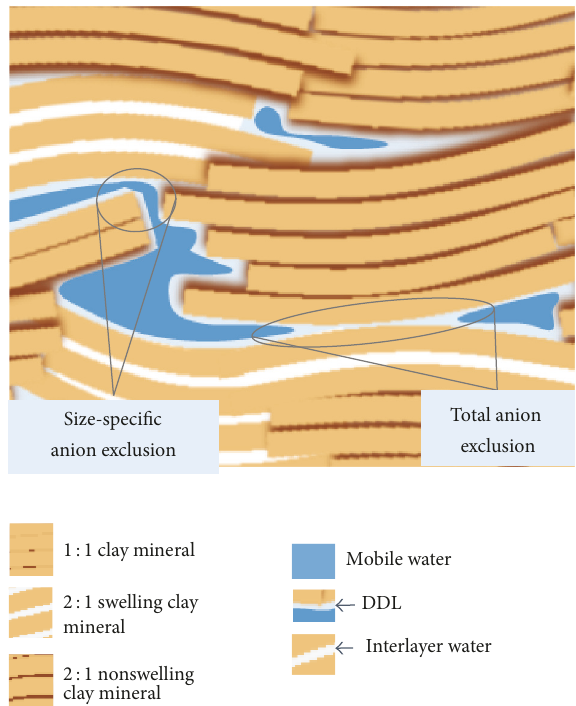
Figure 1: Pore-scale conceptual model for clay-rich sedimentary rock. A variety of clay minerals are depicted, including 1: 1 clay minerals, such as kaolinite, 2 :1 nonswelling clay minerals, such as illite, and 2 :1 swelling clay minerals such as smectite. The negatively charged surfaces of these minerals are balanced with cation-rich water in the DDL and in the interlayer positions of the swelling clay minerals. Mobile water is found in the larger pore